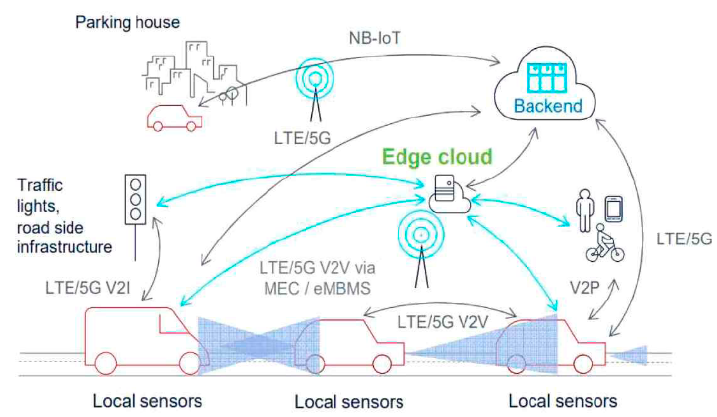
Figure 2. V2X (Vehicle-to-Everything) environment.